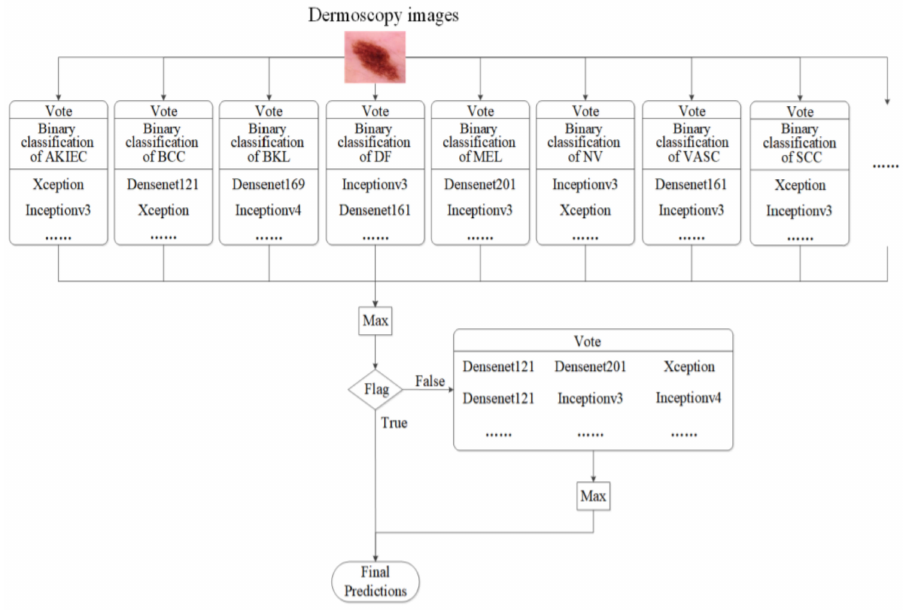
Figure 27. Ensemble strategy of the group decision [52].